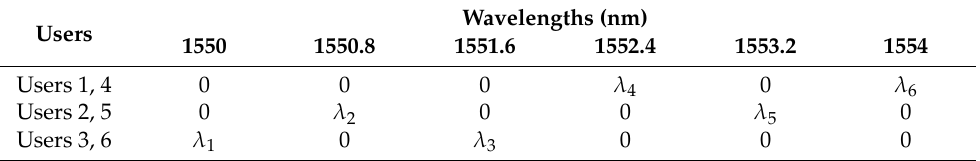
Table 3. Users assigned with ZCC code and their corresponding